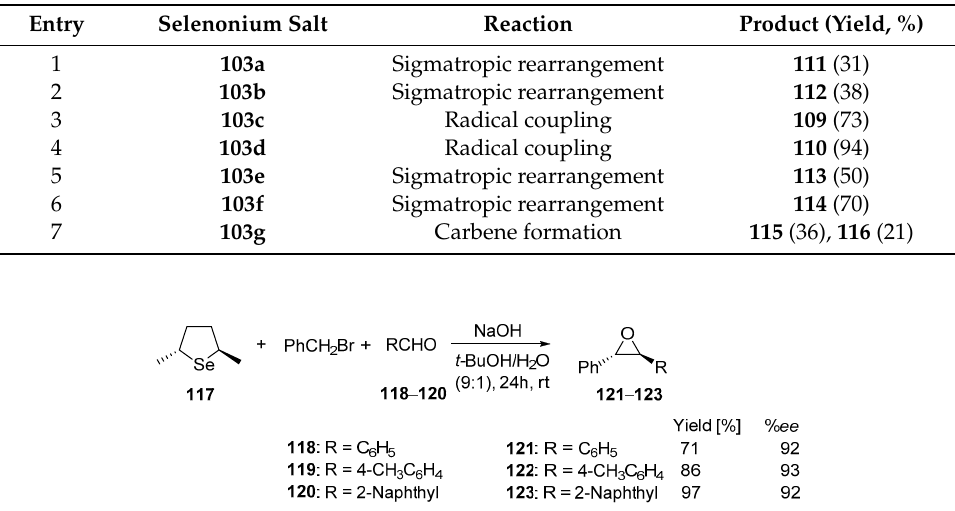
Table 8. Electrochemical reduction of selenonium salts 103a – g without